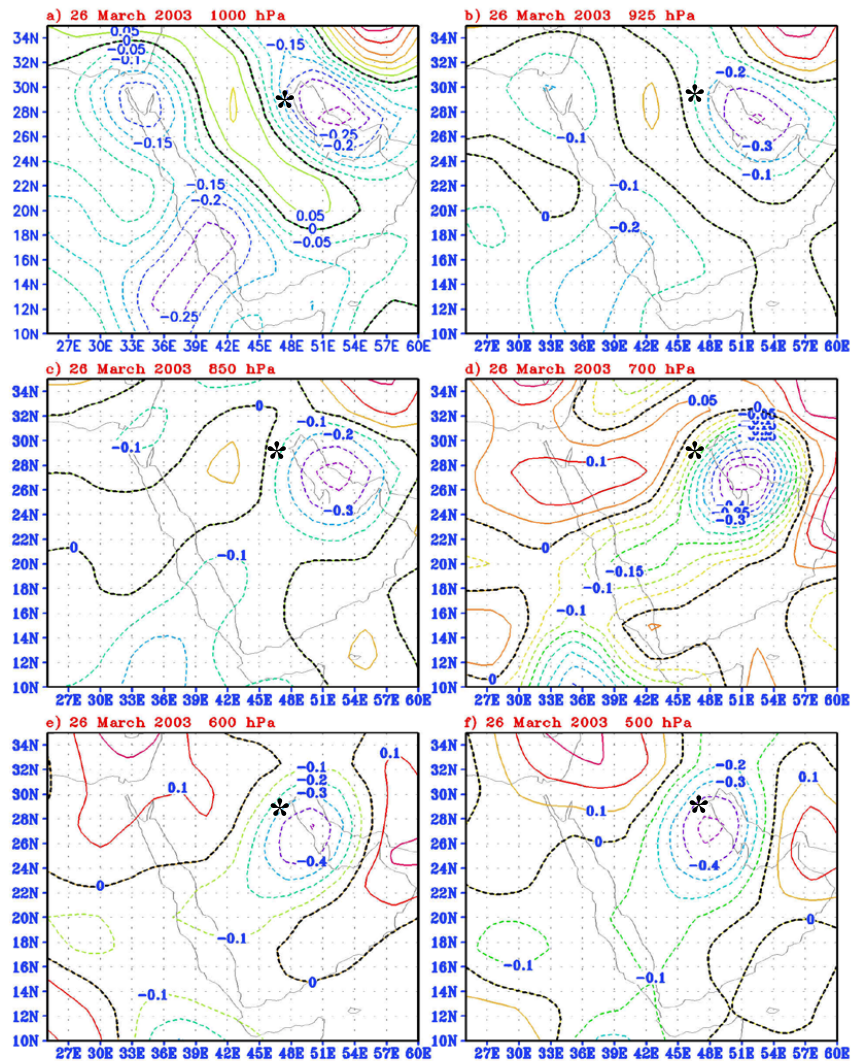
Fig. 5. Horizontal distribution of the vertical motion ( ω ) at different geopotential heights on 26 March. The star symbol ( ∗ ) indicates the location of Kuwait.